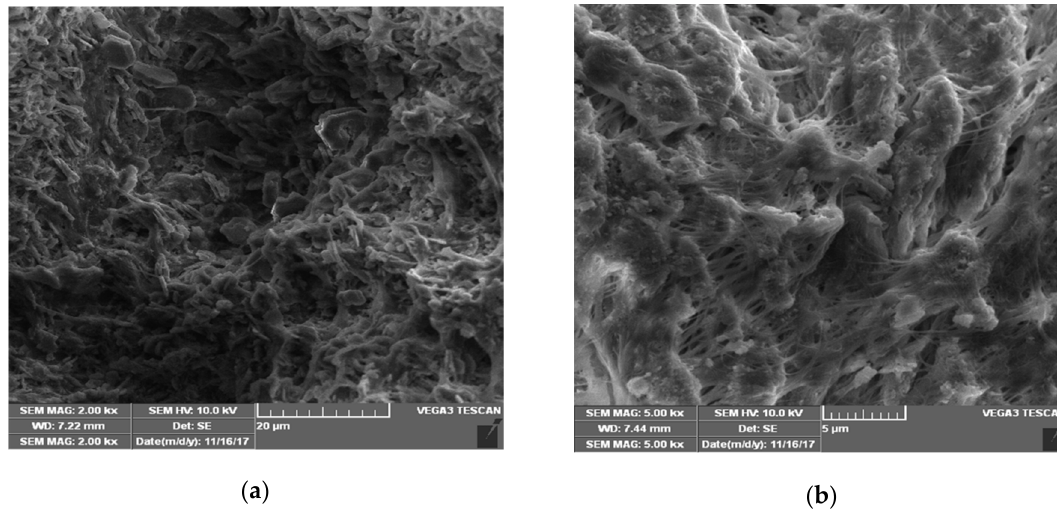
Figure 1. SEM images of CSP at ( a ) low and ( b ) high magnification.